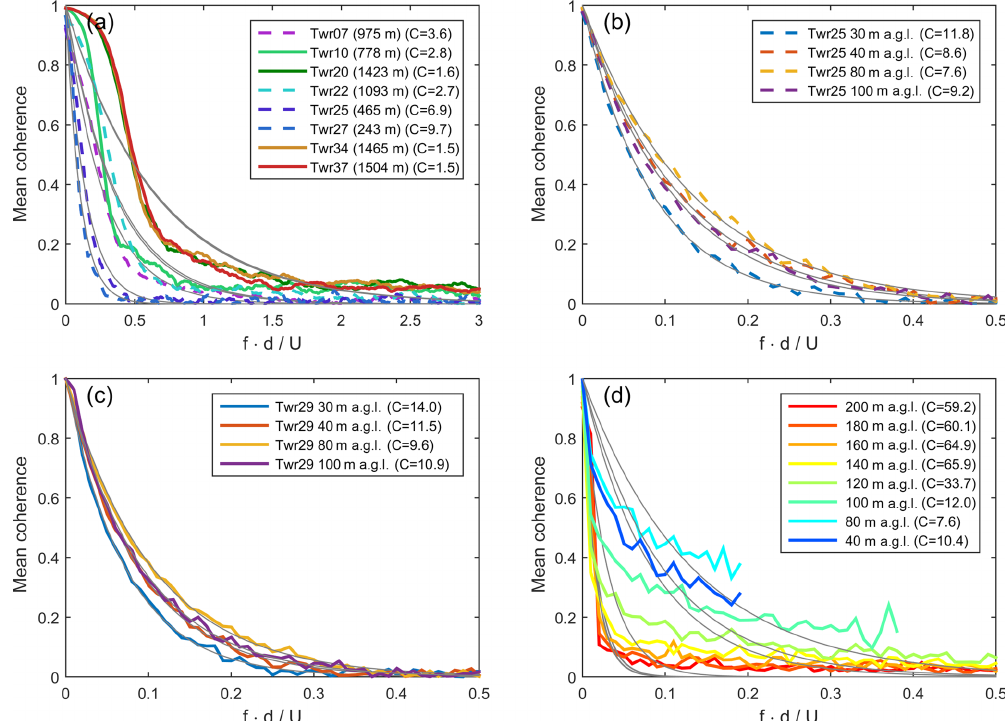
Figure 13. Mean coherence in longitudinal wind speeds as measured by sonic anemometers based on 2h time series. (a) Mean coherences between Tower 29 and each other tower, for a 60m measurement height, and exponential fits thereto. (b) Coherences between each height and the 60m reference height at Tower 20. (c) Coherences between each height and the 60m reference height at Tower 25. (d) Coherence in horizontal wind speed at each height and the 60m reference height measured by ZephIR lidar